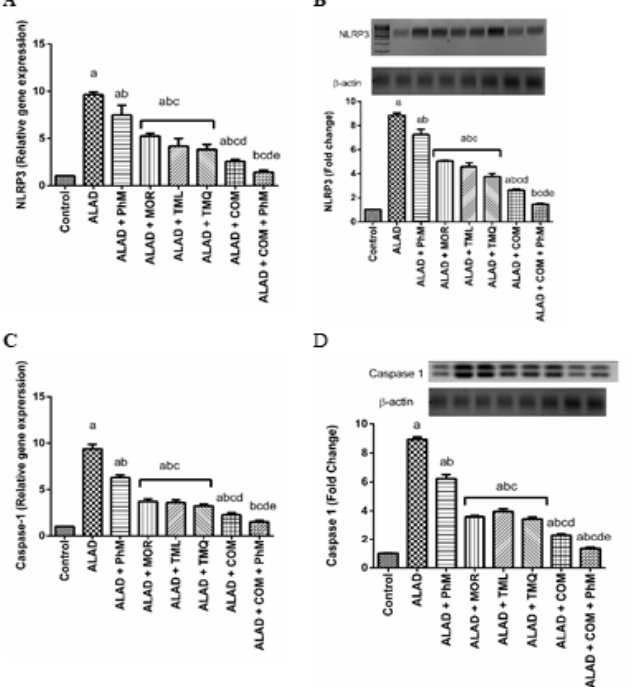
Figure 9. The effect of phytochemicals combination, MOR, TML, and TMQ, with PhM on inflam- masome signaling in AD. ( A ) Relative gene expression of NLRP3, ( B ) Folds of NLRP3 protein expression, ( C ) Relative gene expression of caspase-1, and ( D ) Folds of caspase-1 protein expression. The data are presented as means ± SD ( n = 7). Significance (a): relative to the control group. Significance (b): relative to the ALAD group. Significance (c): relative to ALAD + PhM group. Significance (d): relative to either ALAD + MOR, ALAD + TML, or ALAD + TMQ group. Significance (e): relative to ALAD + COM group Significance: p < 0.05. The data of the effect of MOR, TML and TMQ on the control are not shown as they were not